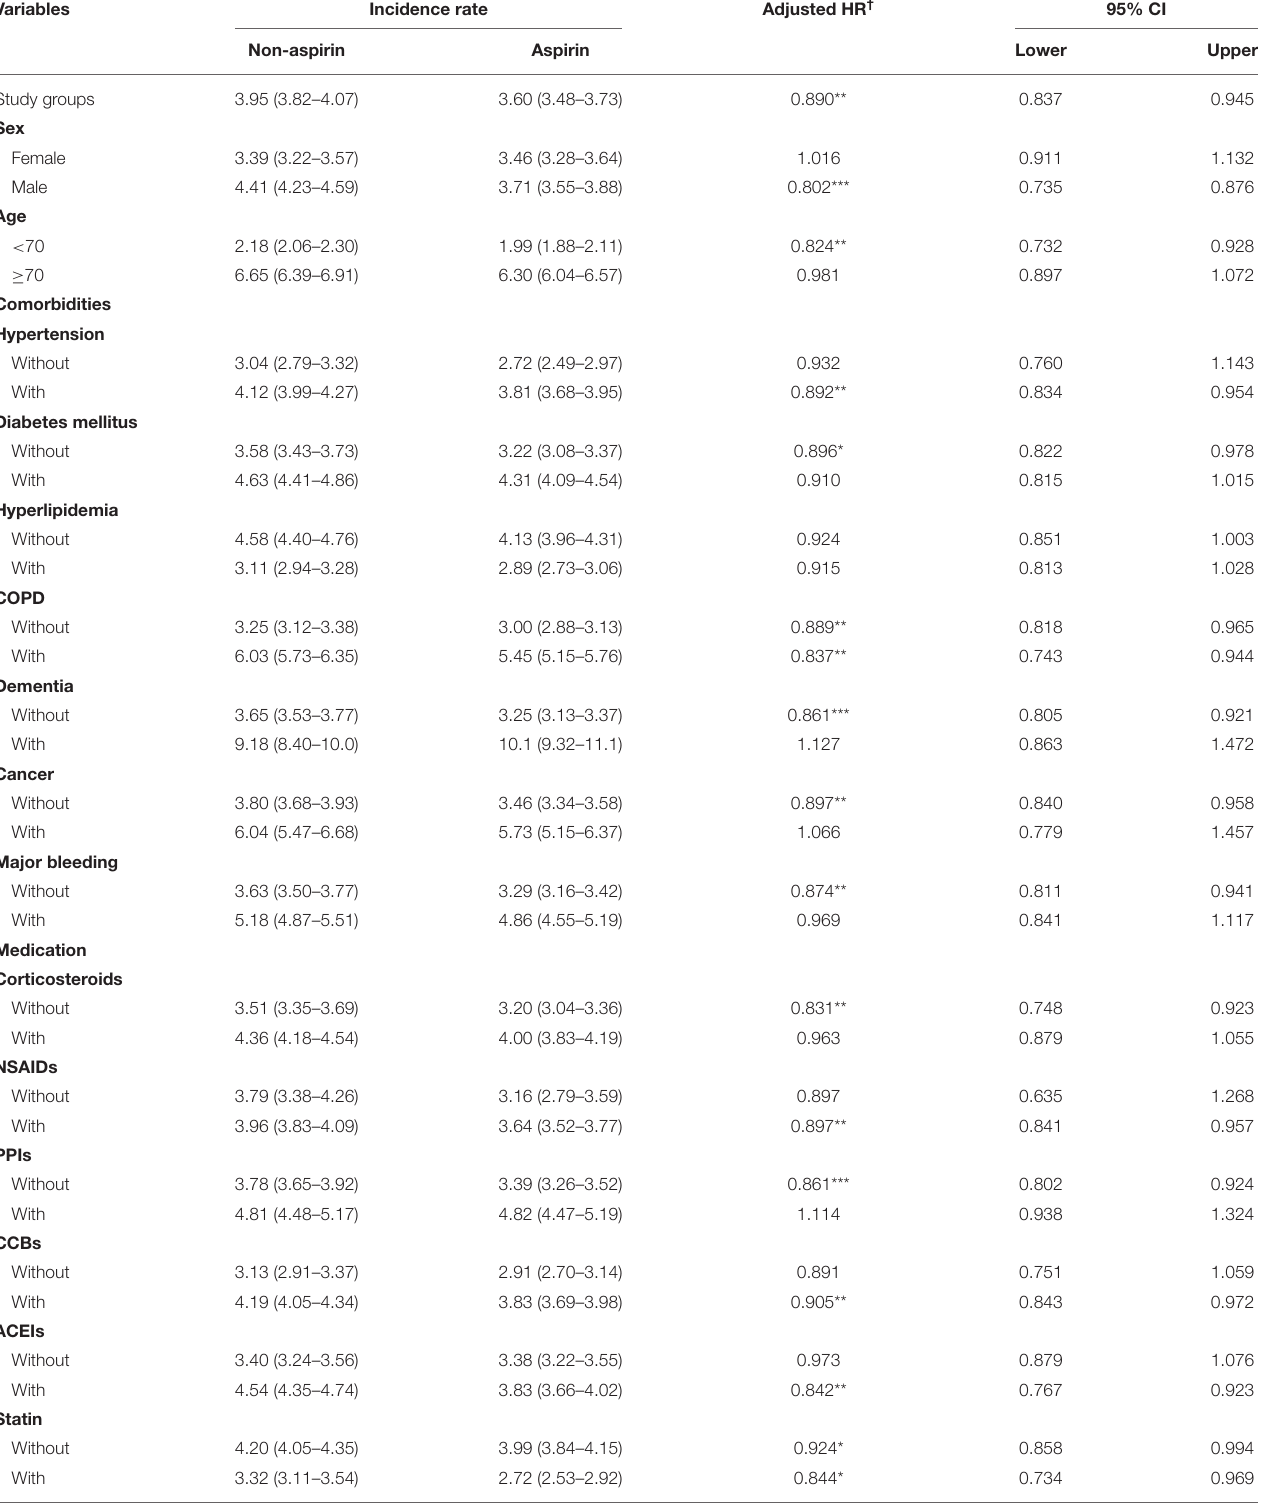
TABLE 3 | Risk of pneumonia among aspirin and non-aspirin groups and stratified